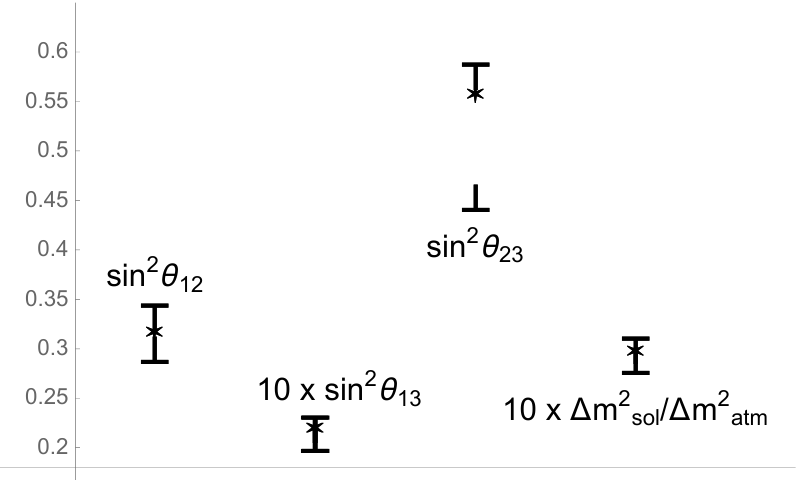
Figure 5 . Mixing angles and ∆ m 2 / ∆ m 2 of 14 pairs of CP and modular invariant models atm sol featuring normal ordering and | τ − i | < 0 . 25 (see text). Shown in the plot are the intervals covered by the model predictions. A star indicates the average over the 14